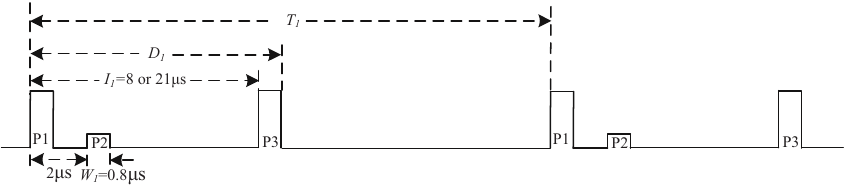
Figure 2. The baseband signal of Secondary Surveillance Radar (SSR)